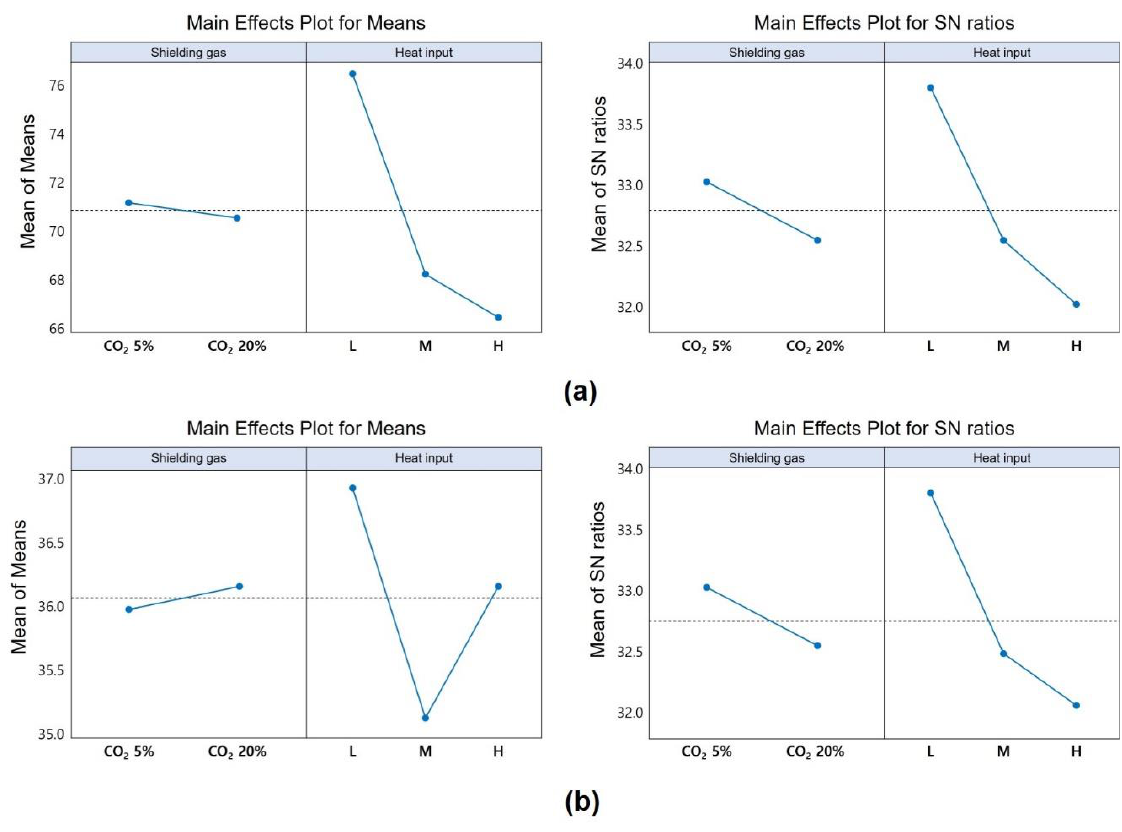
Figure 14. Taguchi results of GMAW with CO 2 5% and 20% shielding gas and heat input: ( a ) Room temperature (20 °C); ( b ) Low temperature ( − 40 °C).